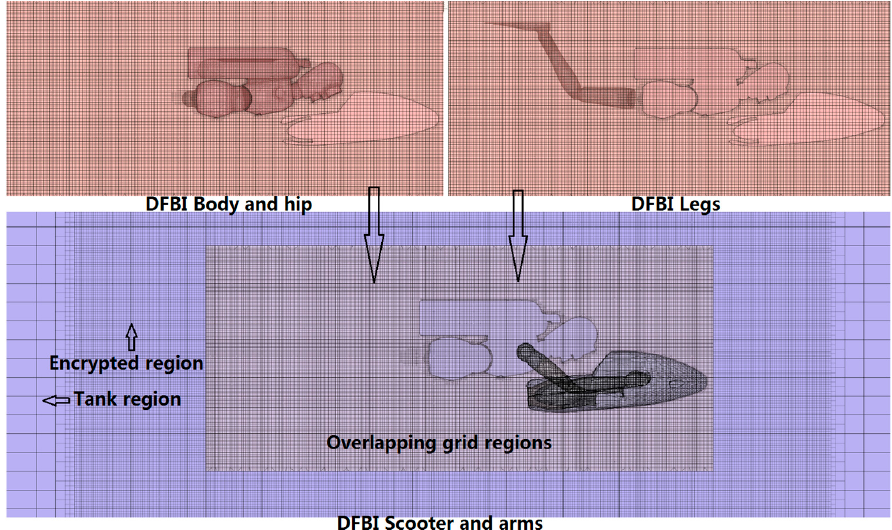
Figure 10. Overlapping grid and encryption region.